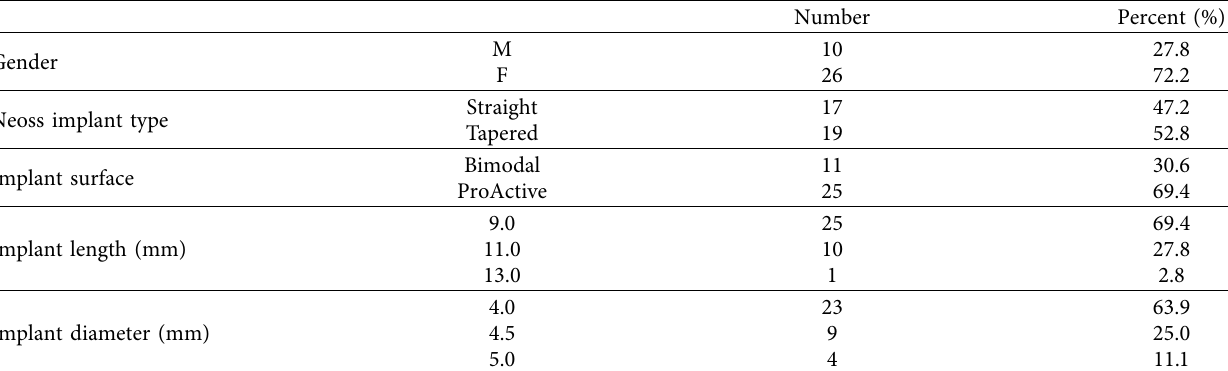
Table 1: Patients and